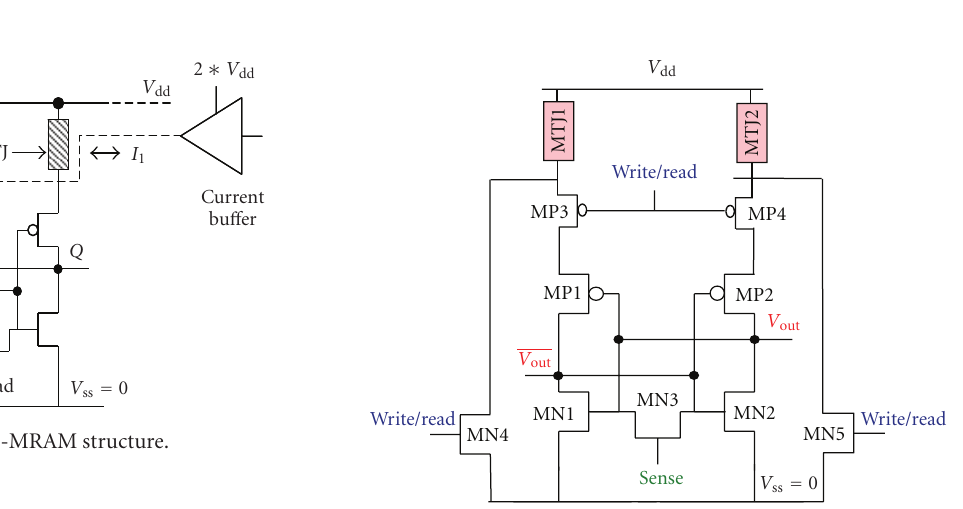
Figure 3: Suppression of the top reading line.